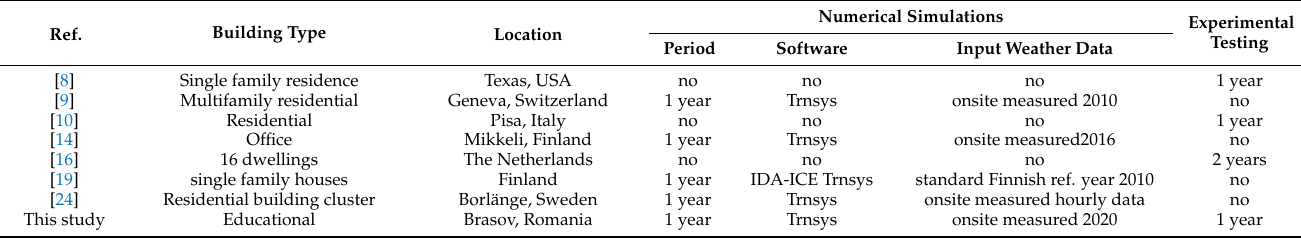
Table 7. Synthesis of the similar studies found in